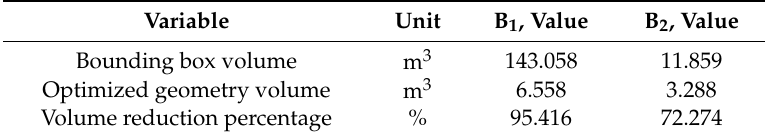
Table 7. Statistics of the volume resulting from the topological optimization algorithm for the bounding boxes B 1 and B 2.